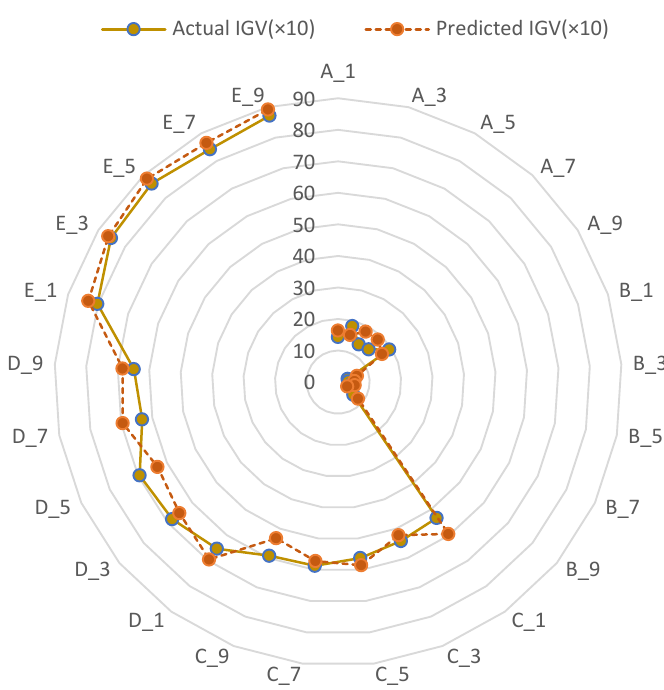
Figure 13. Demonstration of the actual and predicted IGV values of chernozem soils on tests A_1 to E_10, implemented on layers A–E, respectively.